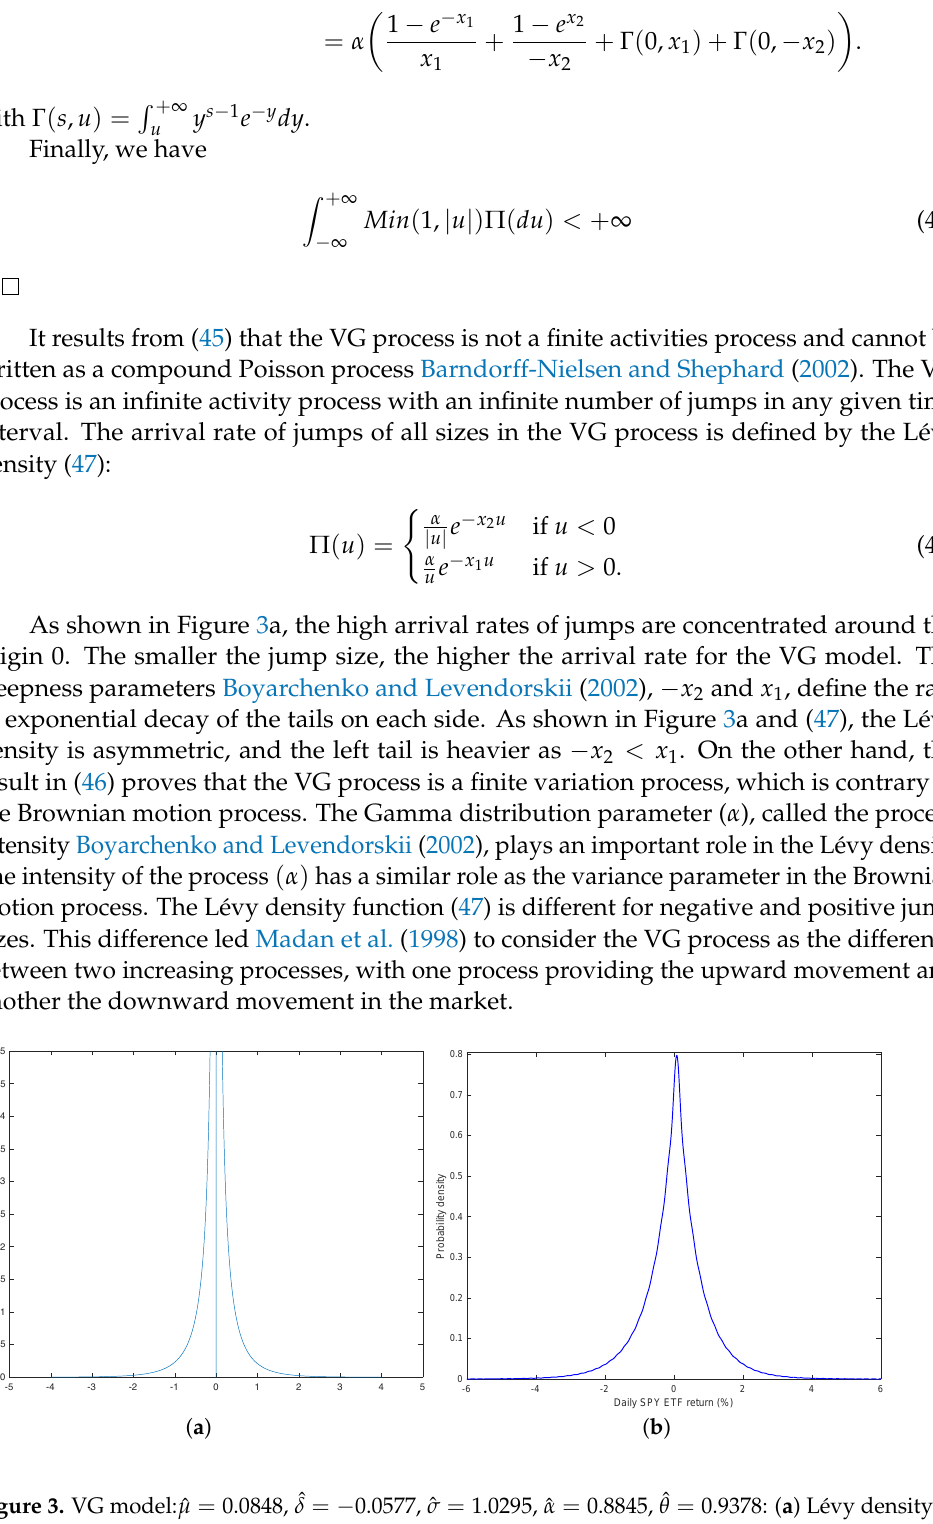
Figure 3. VG model: ˆ µ = 0.0848, ˆ δ = − 0.0577, ˆ σ = 1.0295, ˆ α = 0.8845, ˆ θ = 0.9378: ( a ) Lévy density of the VG model and ( b ) Probability density of the VG